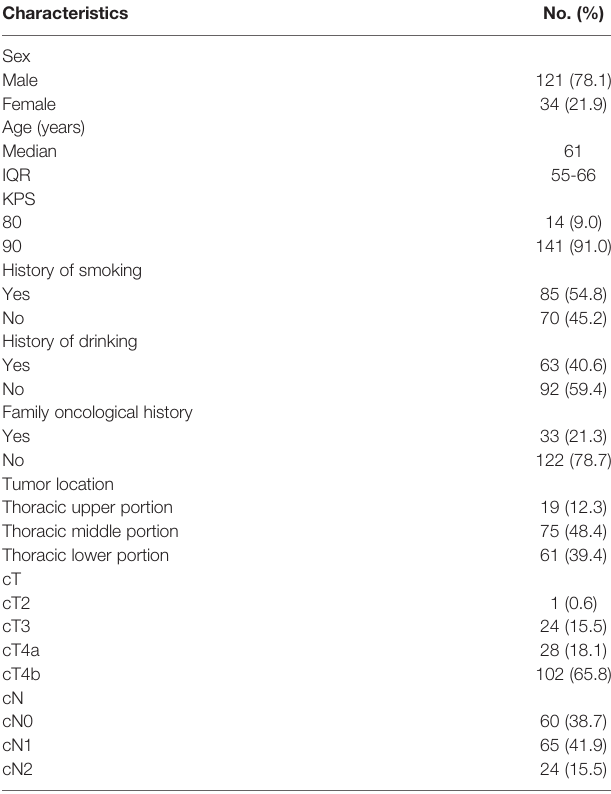
TABLE 1 | Clinicopathological characteristics of the RICE